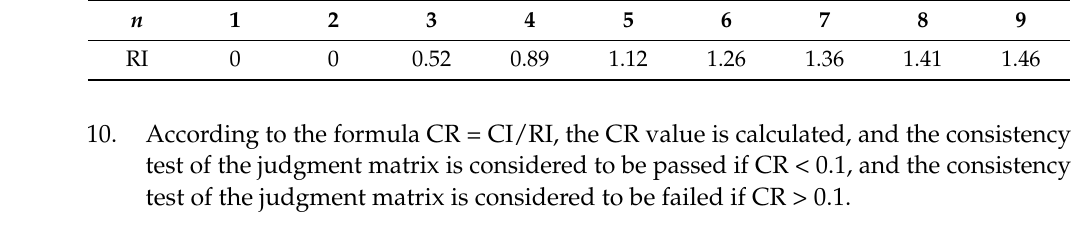
Table 7. Average random consistency